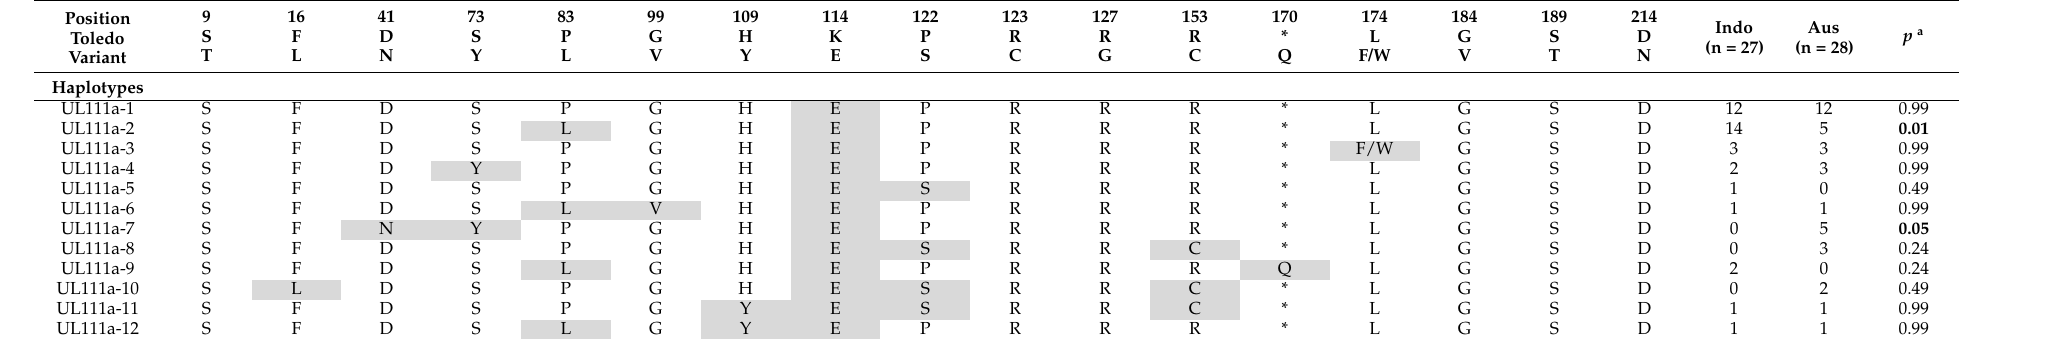
Table 2. Haplotype UL111a-2 is frequently found in HCMV from Indonesian samples.